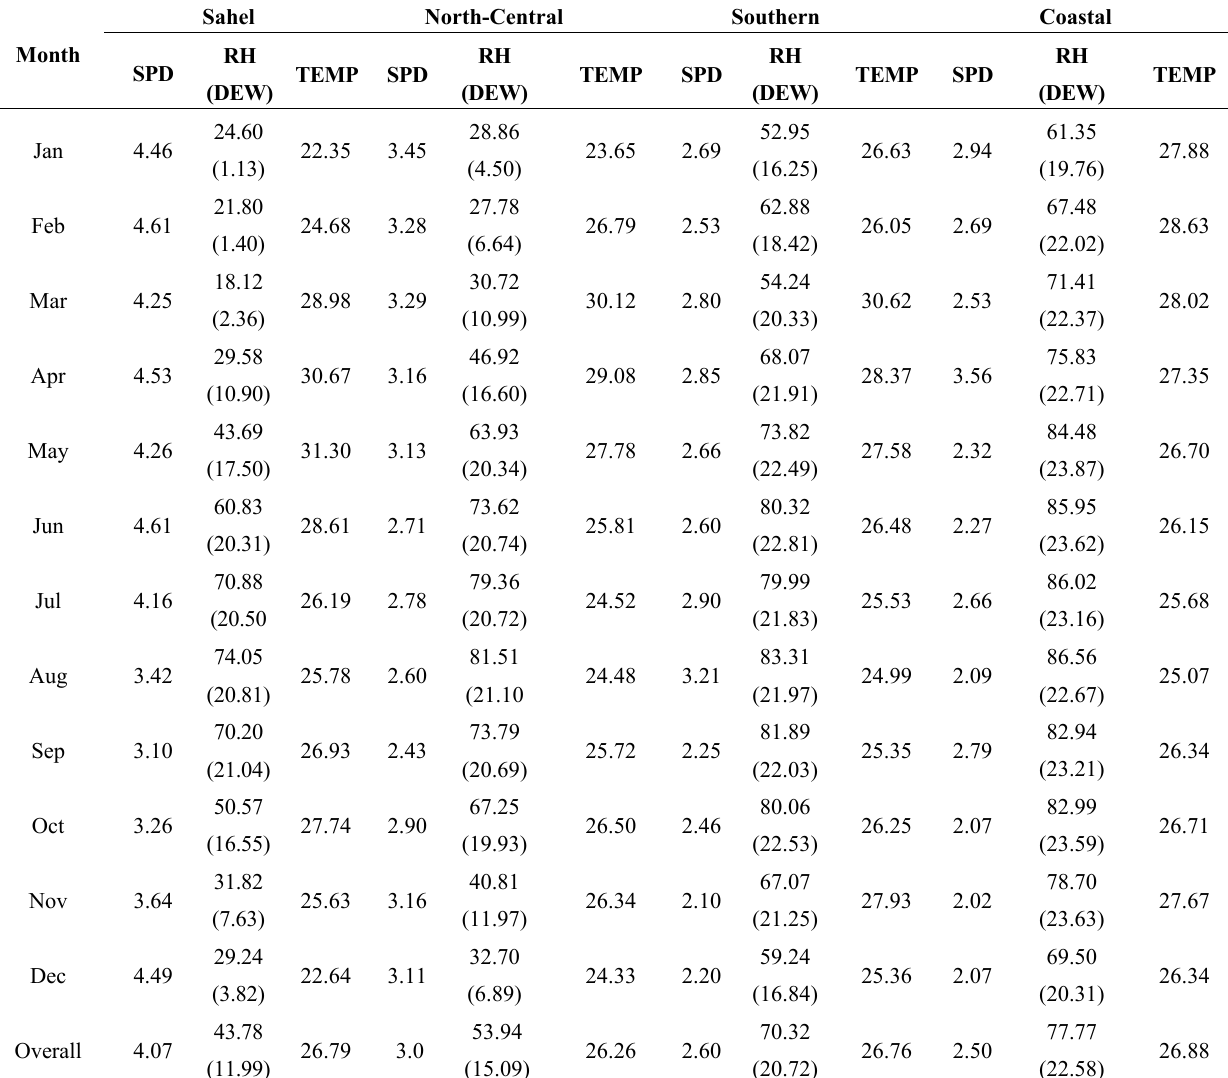
Table 2. Variation of monthly and overall climatic condition over 30year period in different zone of